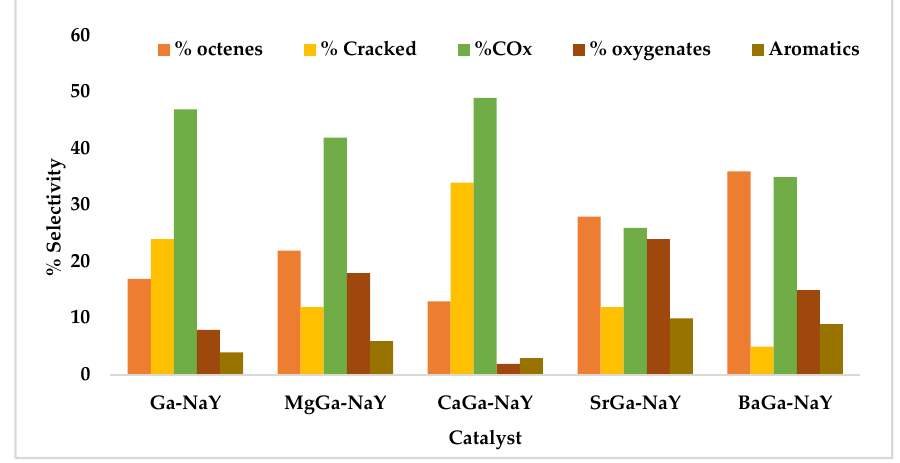
Figure 7. Products selectivity towards cracked products, aromatics, carbon oxides, oxygenates and octene isomers at iso ‐ conversion (6 ± 1%) of n ‐ octane at a fixed temperature of 450 °C.